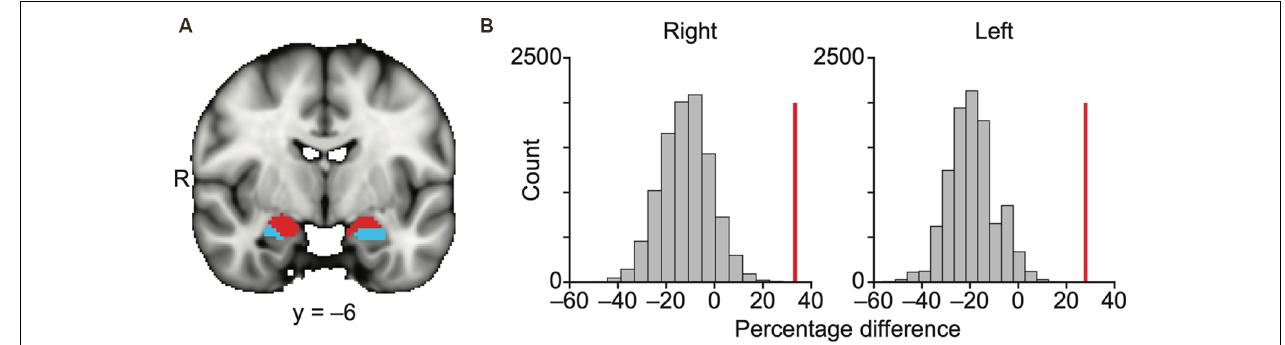
FIGURE 2 | Olfactory and non-olfactory areas of the amygdala are delineated using resting state connectivity. (A) Results of k-means ( k = 2) clustering of the amygdala based on resting state connectivity. Each color (red and blue) in panel (A) indicates one cluster. The data are shown on the FSL’s MNI152_T1_1 mm_brain. (B) Bar plots indicate the distribution of permuted difference of the percentage of the olfactory subregions within each parcellation. The red vertical line indicates real value. Data are shown for the right and left hemispheres separately. R, right